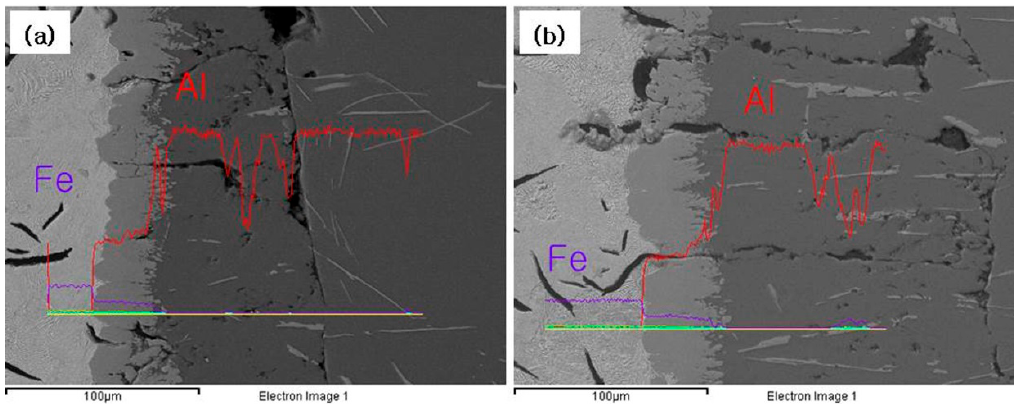
Table 2. Concentrations (at.%) of intermetallic compounds (C) at the interface of cast iron/liquid aluminum and aluminum matrix (A) near the interface with respect to the holding time (the numbers in parenthesis indicate weight percent).